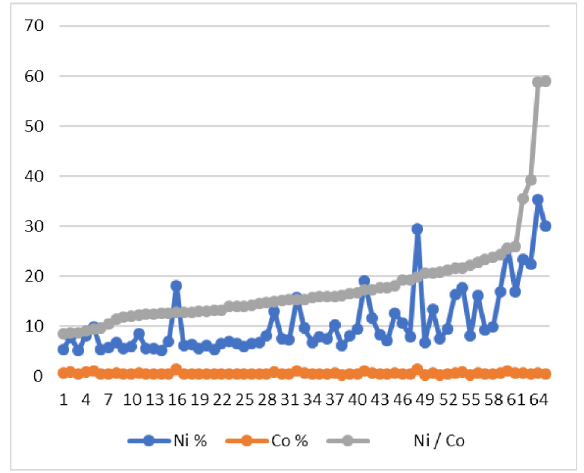
Figure 5. Linear plot Co against Ni for iron meteorites (data from Table 2). r = 0.51. Δ octahedrites, o hexahedites, ¡ ataxites, ◊ anomalous.